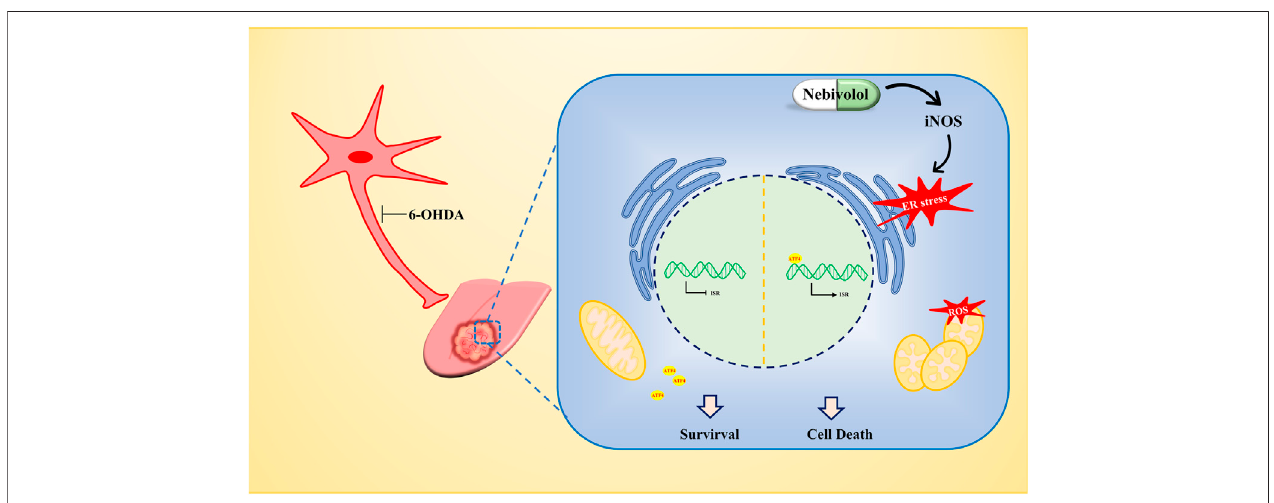
FIGURE 7 | The antitumor mechanism of nebivolol in OSCC cells. Nebivolol triggered the accumulation of iNOS to activate ER stress. Meanwhile, mitochondrial dysfunction was stimulated to enhance ROS level to induce apoptosis in nebivolol-treated OSCC cells.